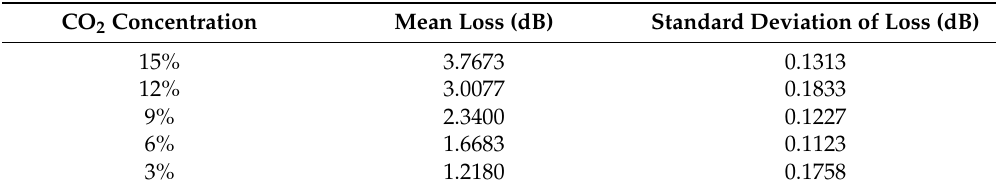
Table 2. Comparison with different sensors used to measure CO 2 concentrations.